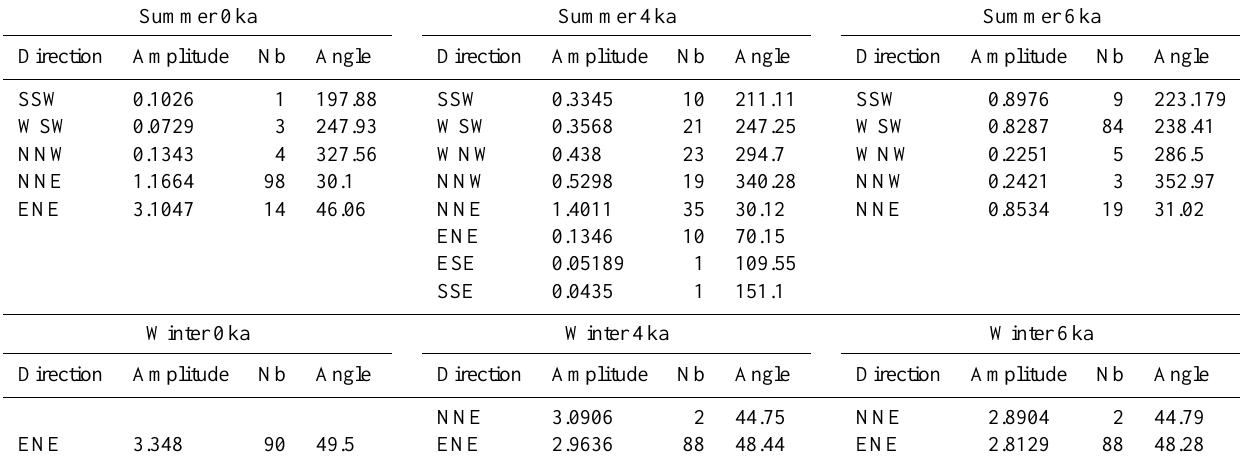
Table 1. Characterization of wind regimes over the Yoa region (17.5–22.5 ◦ E, 17–22 ◦ N) as reconstructed from the atmospheric simulations for 0ka, 4ka and 6ka from daily